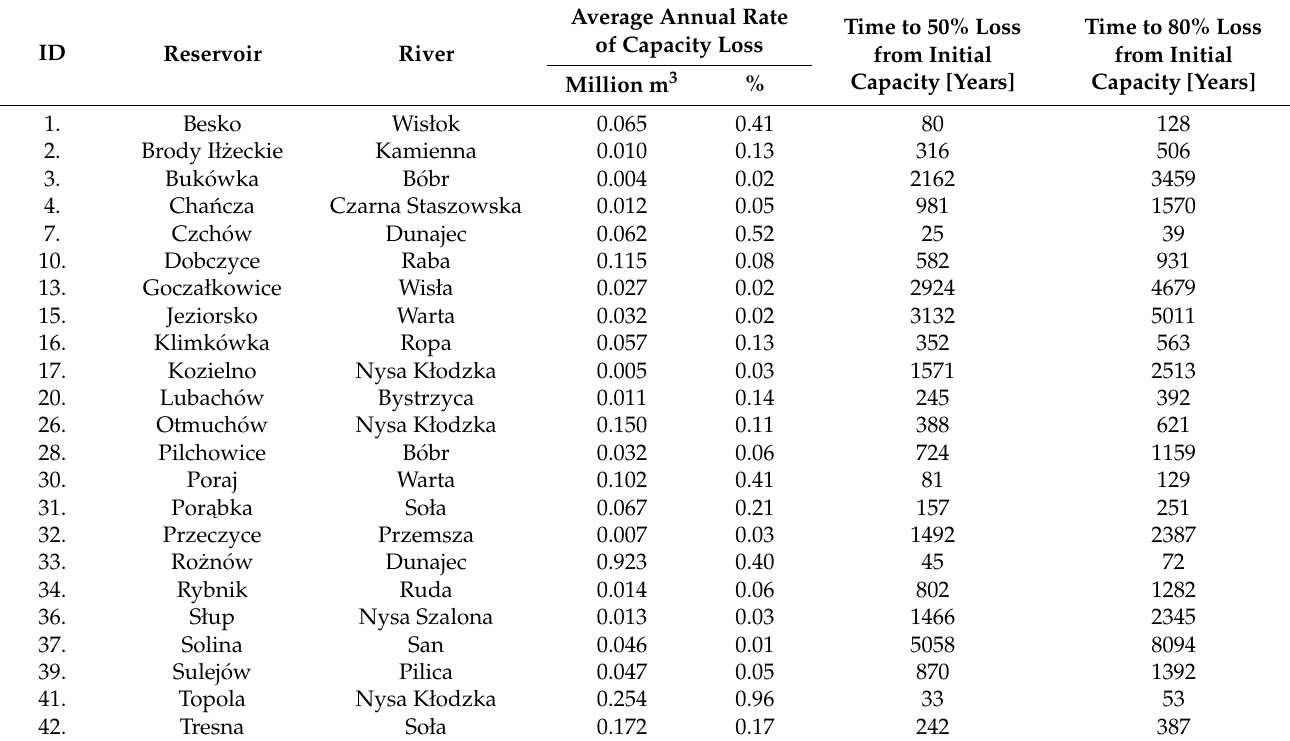
Table 2. The rate of volume change in reservoirs of key importance for water management in Poland, belonging to the classes of volume changes from I to III.